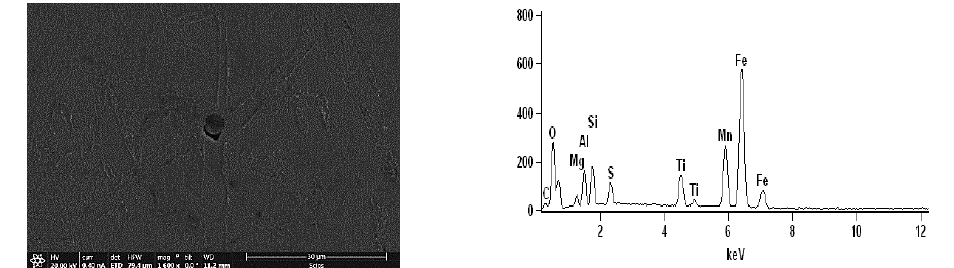
Figure 8. EDS (energy-dispersive spectroscopy) spectra of the typical complex inclusions in testing